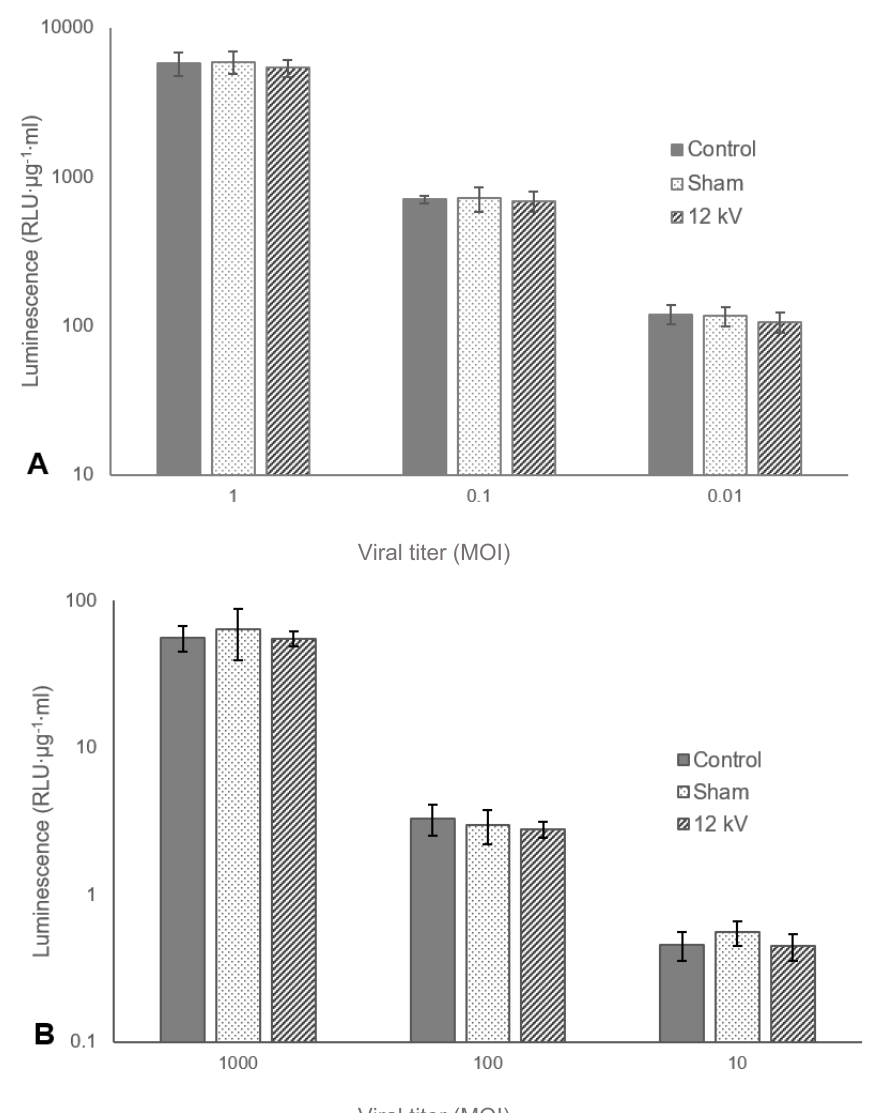
Figure 2. Mean average luminescence, represented as relative light units (RLU) adjusted for protein concentration, measured after lysis of cells incubated with either electrosprayed modified vaccinia Ankara (MVA) ( A ) or adenovirus (Ad) ( B ) at three multiplicities of infection (MOIs). Working distance: 7.25cm, flow rate: 10 µ L / min. Error bars represent the standard deviation ( n =